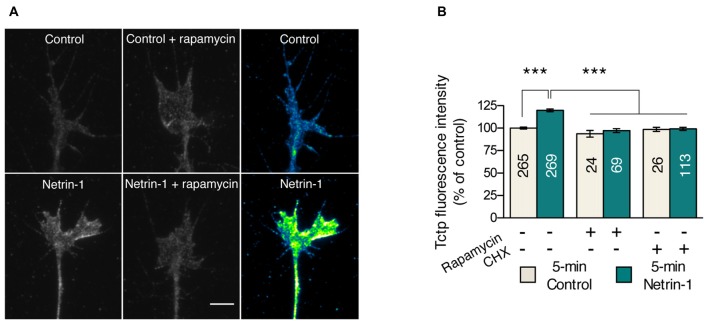
Netrin-1 triggers a translation-dependent rise in growth cone translationally controlled tumor protein (Tctp). (A,B) Retinal explants were stimulated with Netrin-1 for 5 min and stained for Tctp. Netrin-1 induced an increase in growth cone Tctp mean intensity signal relative to control, and this effect was prevented by rapamycin or cycloheximide (CHX) pre-treatment (mean ± SEM; n = no. of growth cones analyzed; ***P < 0.0001, Kruskal-Wallis test). Scale bars: 5 μm.